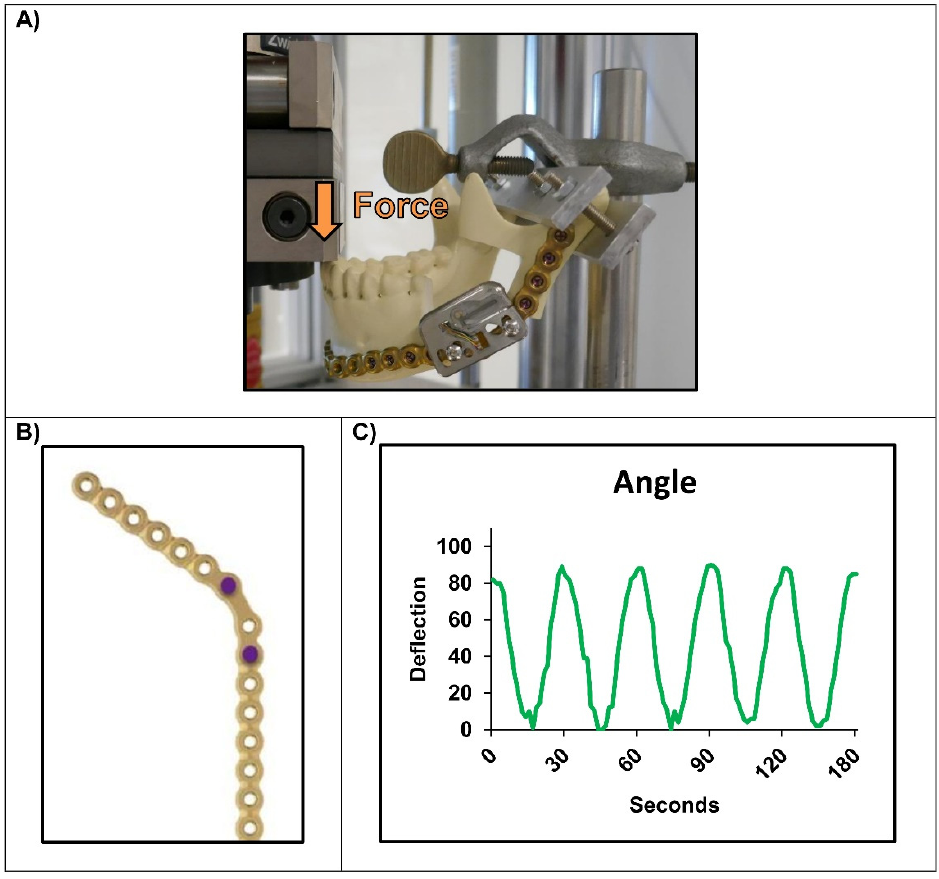
Figure 4. Simulation of the mounted strain measurement device on an artificial defect in the mandibular angle (displacement 1.5 mm; f = 0.5 Hz): ( A ) Mounted sensor to the mandible; ( B ) Used holes for fixation of the device; ( C ) Nearly perfect registration of the sinusoidal force being applied to the incisors.